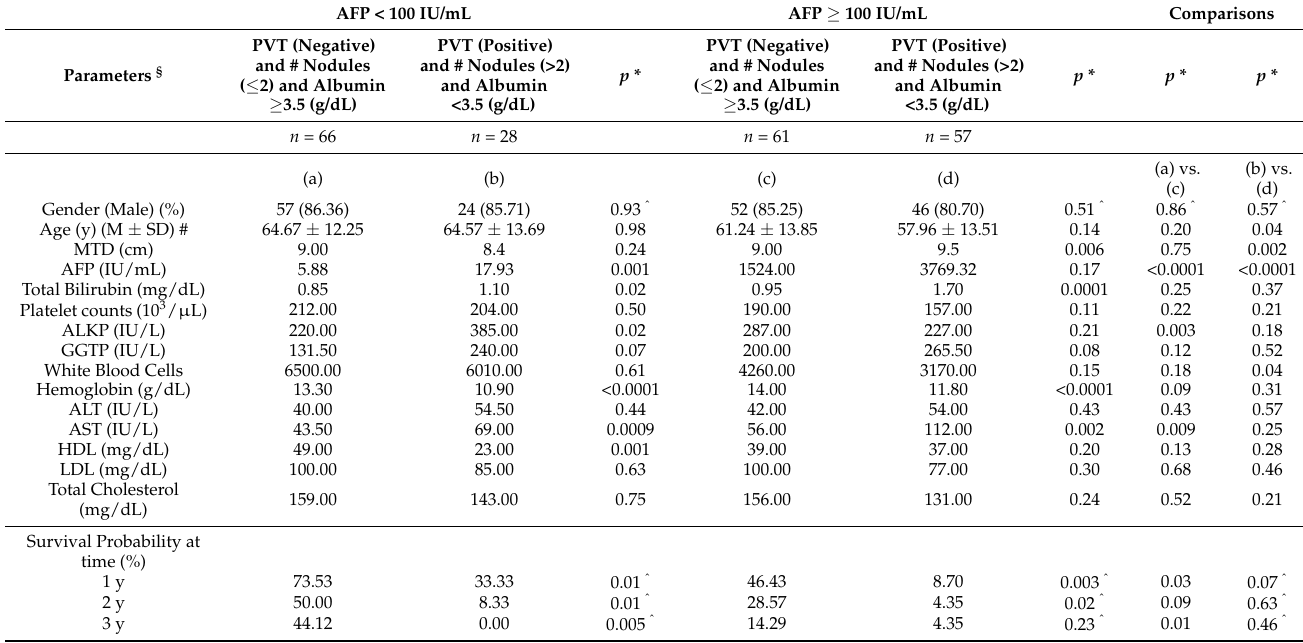
Table 3. Clinical and tumor parameter values according to combinations of PVT, multifocality, and albumin, subdivided into AFP in categories in HCC patients with MTD (8–11)